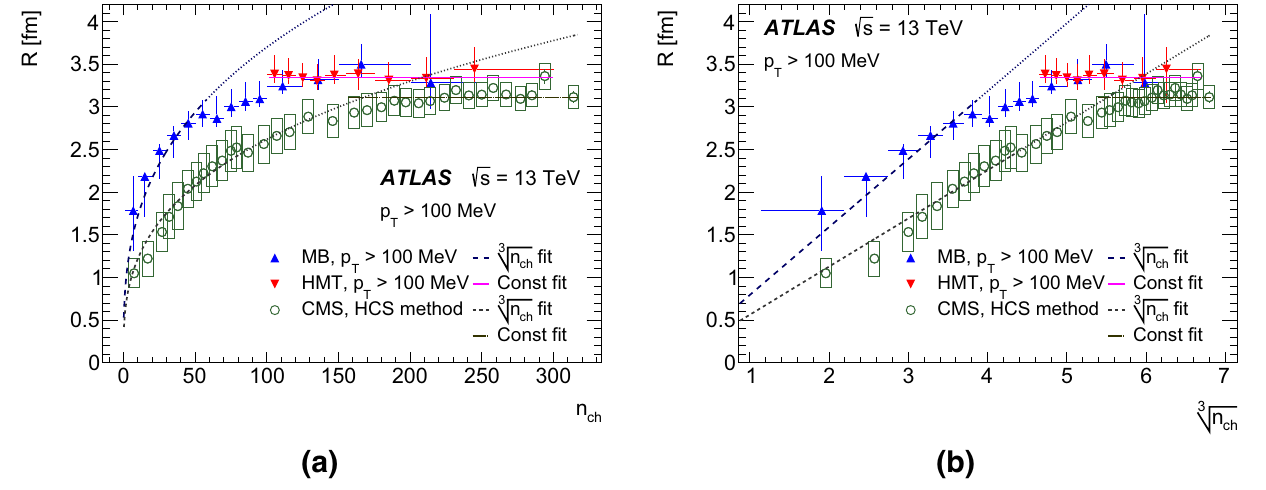
are shown since the statistical uncertainties are smaller than the marker size. The dashed blue (ATLAS) and black (CMS) lines represent the √ n ch at low multiplicity, continued as dotted lines beyond the fit fit to 3 range. The solid green (ATLAS) and broken black (CMS) lines indicate the plateau level at high